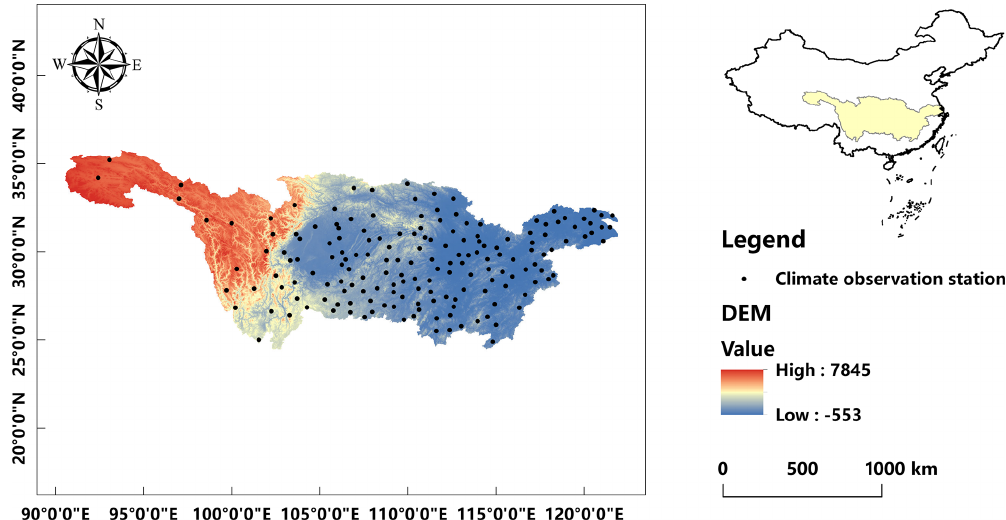
Figure 1. The location and topography of the Yangtze River basin and the location of climate observation